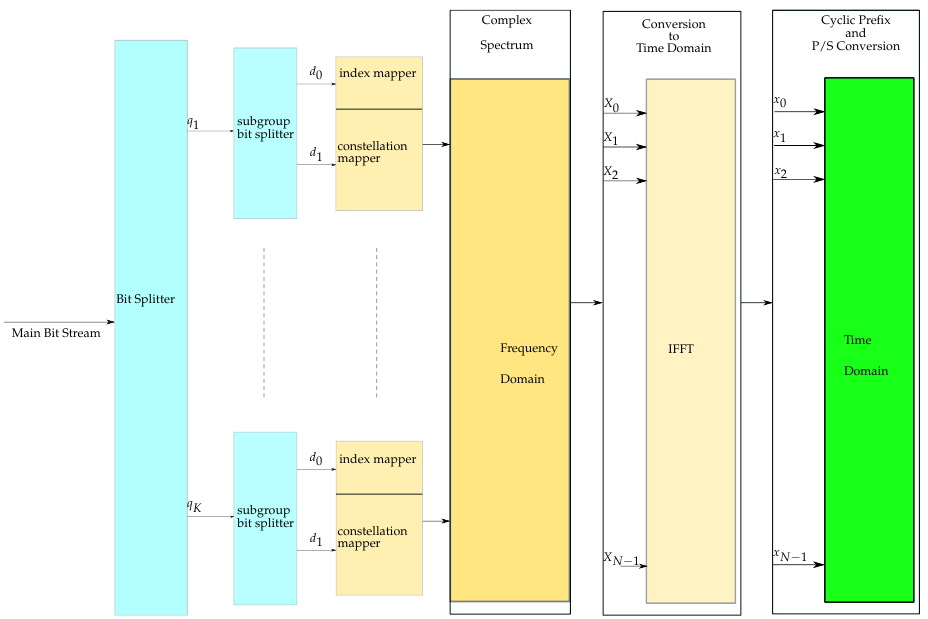
Figure 2. OFDM-IM system